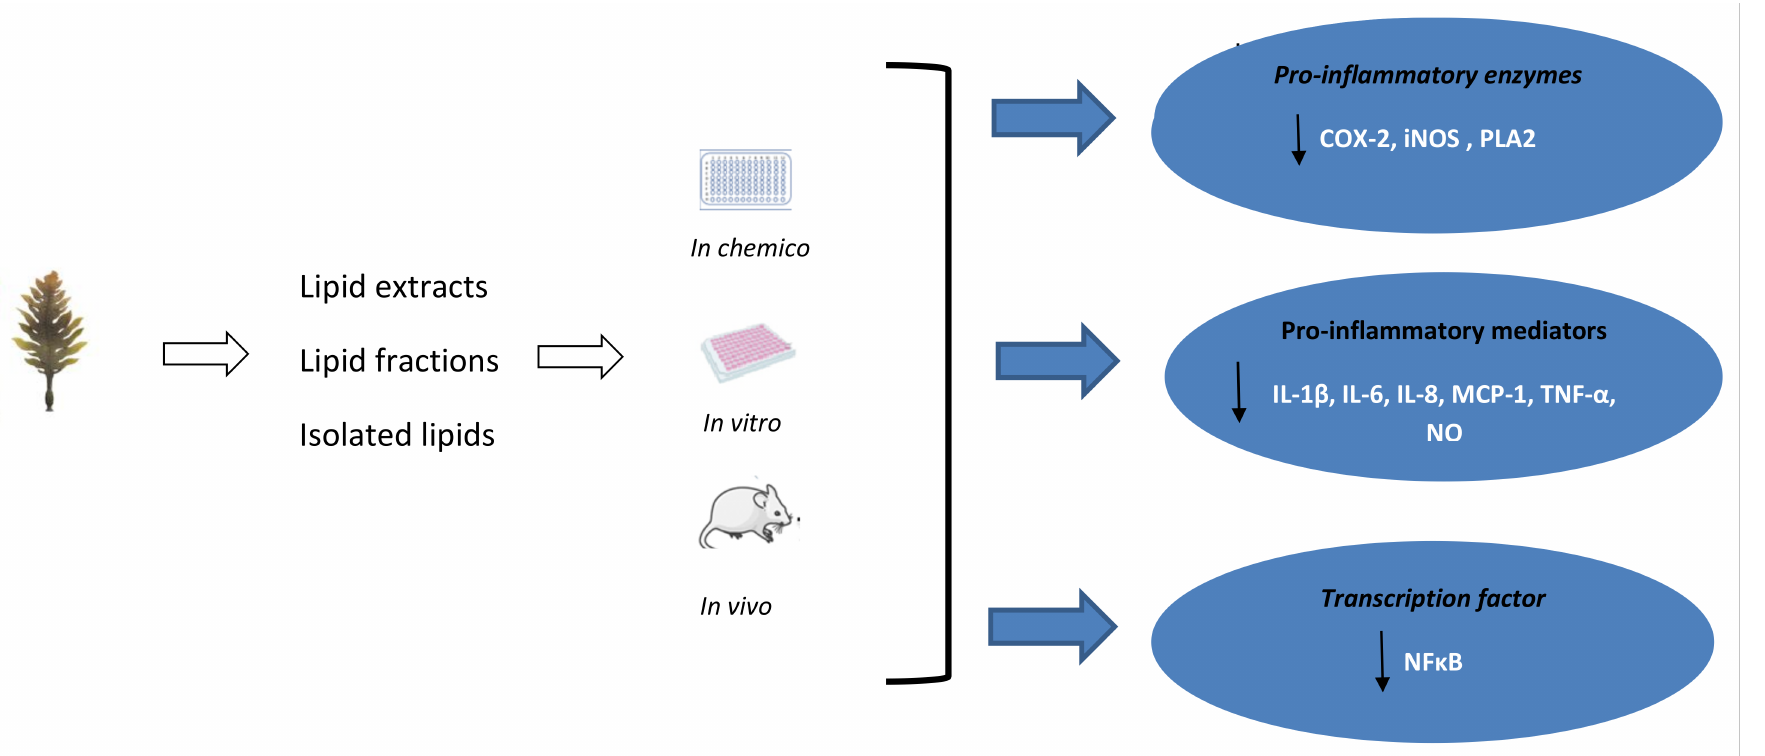
Figure 2. Schematic representation of the anti-inflammatory effects of seaweed